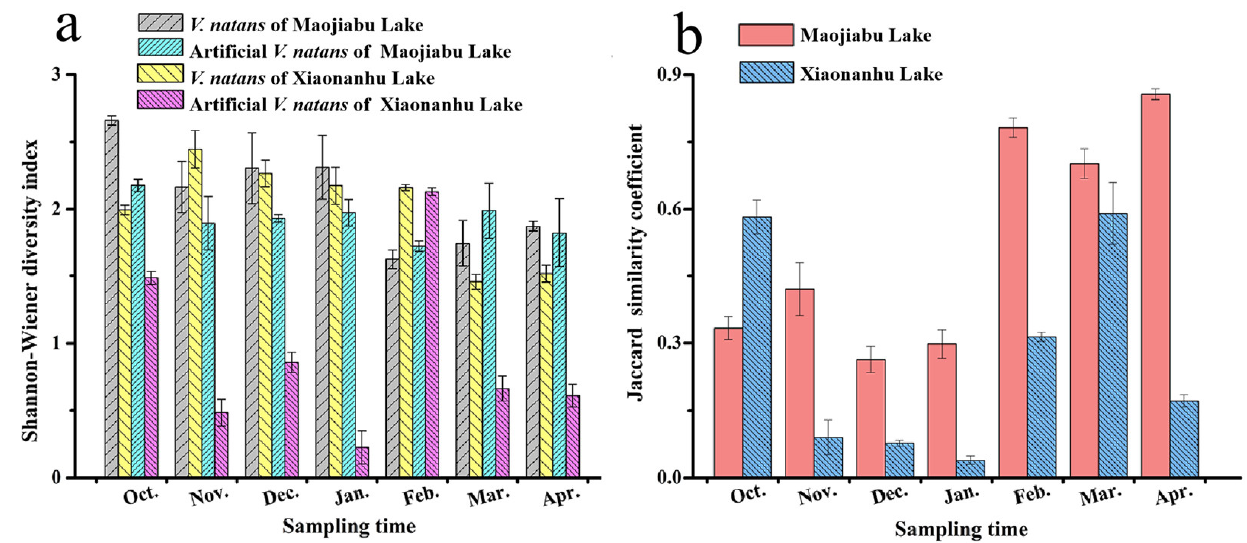
Figure 5. Shannon–Wiener diversity index ( a ) and Jaccard similarity coefficient ( b ) of periphytic algae at different times and sampling lakes. Error bars show the standard deviations (n = 3).